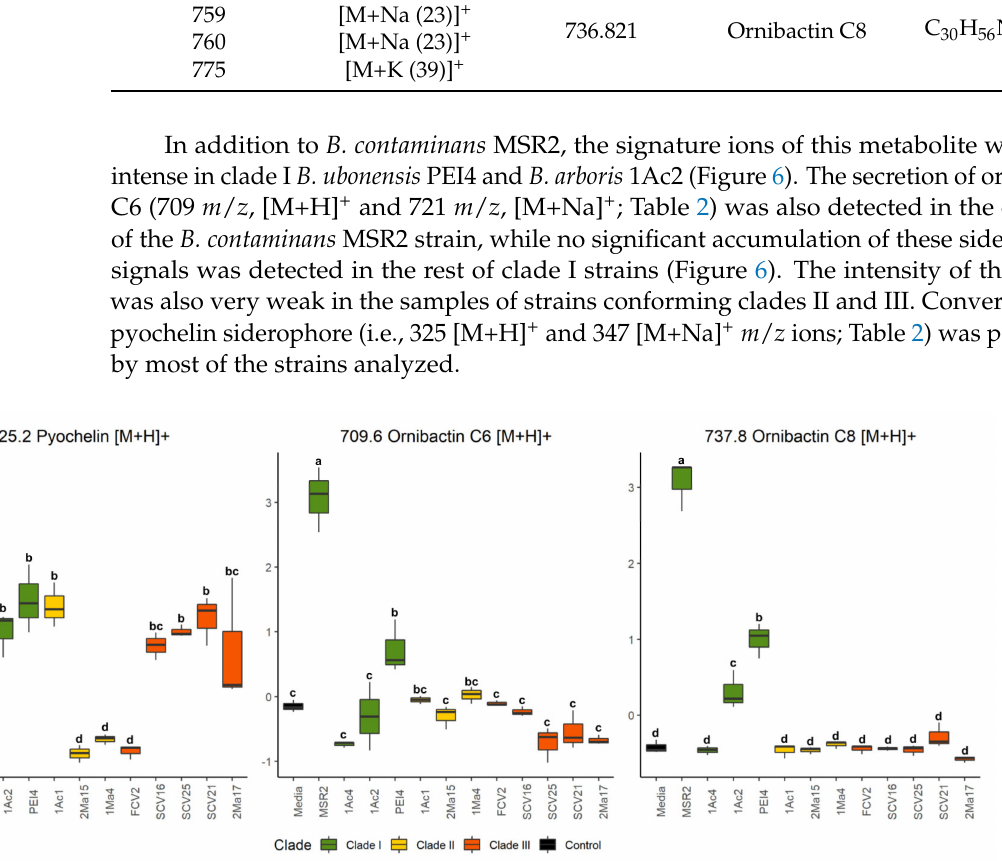
Figure 6. Quantification of siderophore accumulation in the culture media of rhizosphere Burkholderia sensu lato strains. The box plots represent the normalized intensities of the ion signals identified as part of the pyochelin ( m / z 325.2), ornibactin C6 (709.6) and ornibactin C8 (737.8) siderophores. These were detected in the culture media used to grow different rhizosphere Burkholderia sensu lato strains. Different letters over the box plots represent statistically significant differences (one-way ANOVA, Tukey test, p < 0.05). The box plot colors are representative of the grouping of the different Burkholderia sensu lato strains: clade I (green), clade II (yellow) and clade III